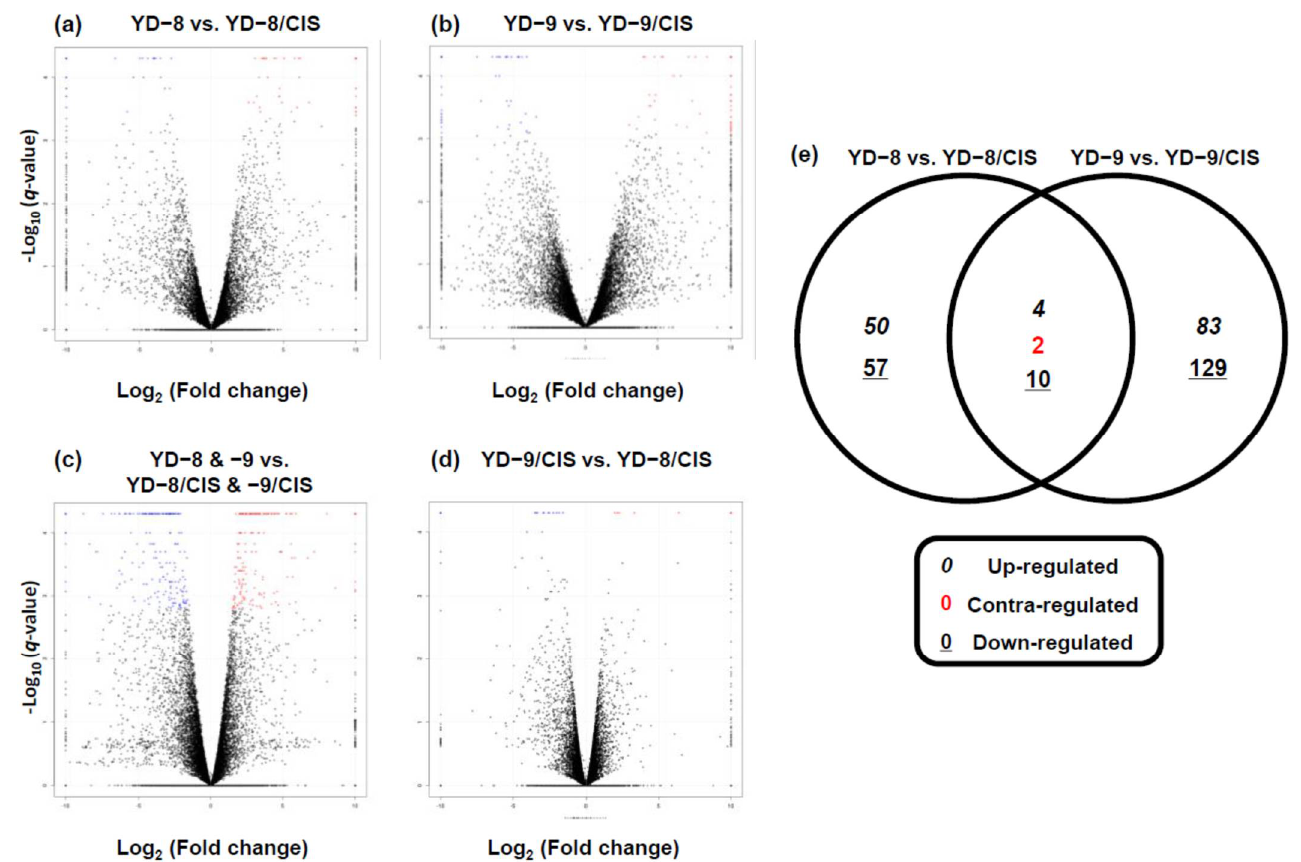
Figure 3. Volcano plots and Venn diagrams of expressed genes. Volcano plot and scatter plot for differentially expressed genes in YD-8 vs. YD-8/CIS ( a ), YD-9 vs. YD-9/CIS ( b ), YD-8 and YD-9 vs. YD-8/CIS and YD-9/CIS ( c ), and YD-9/CIS vs. YD-8/CIS ( d ). In the volcano plots, the X -axis is value of fold change and the Y -axis is q -value, which indicates the significance level of the expression difference. The red dots represent significantly upregulated genes with at least two-fold change and the blue dots represent significantly downregulated genes with at least two-fold change. ( e ) Venn diagrams showing the number of differentially expressed transcripts ( p -value < 0.05) in the YD-8 and YD-9 samples relative to the cisplatin-resistant samples (YD-8 vs. YD-8/CIS and YD-9 vs. YD- 9/CIS datasets). The Venn diagram was made using an online tool “Calculate and draw custom